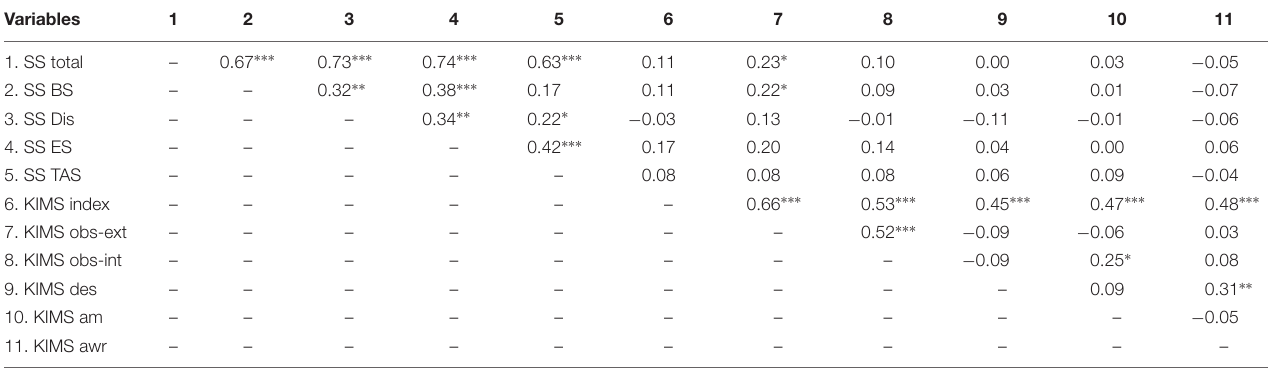
TABLE 2 | (Partial) correlations of the independent variables.